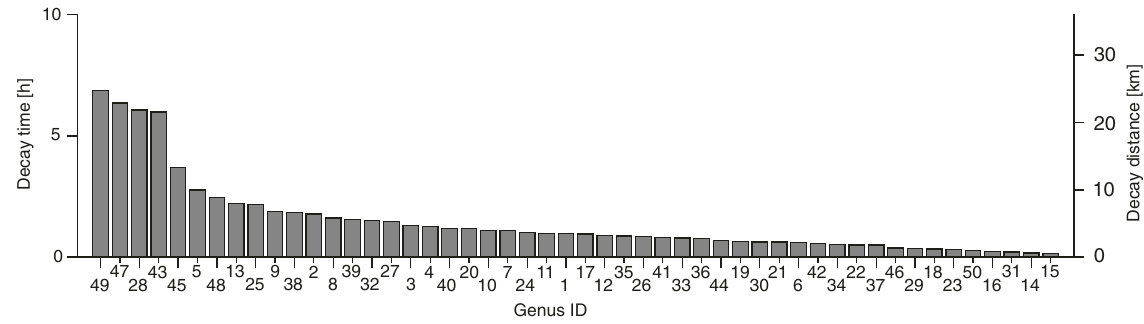
Fig. 3 Estimates of decay times. Values displayed correspond to the medians of the sampled posterior distributions. Genus IDs are as in Supplementary Data 1. The right y -axis converts decay times into distances, by assuming a constant water velocity equal to 1 ms − 1 . Source data are provided as a Source Data fi le.